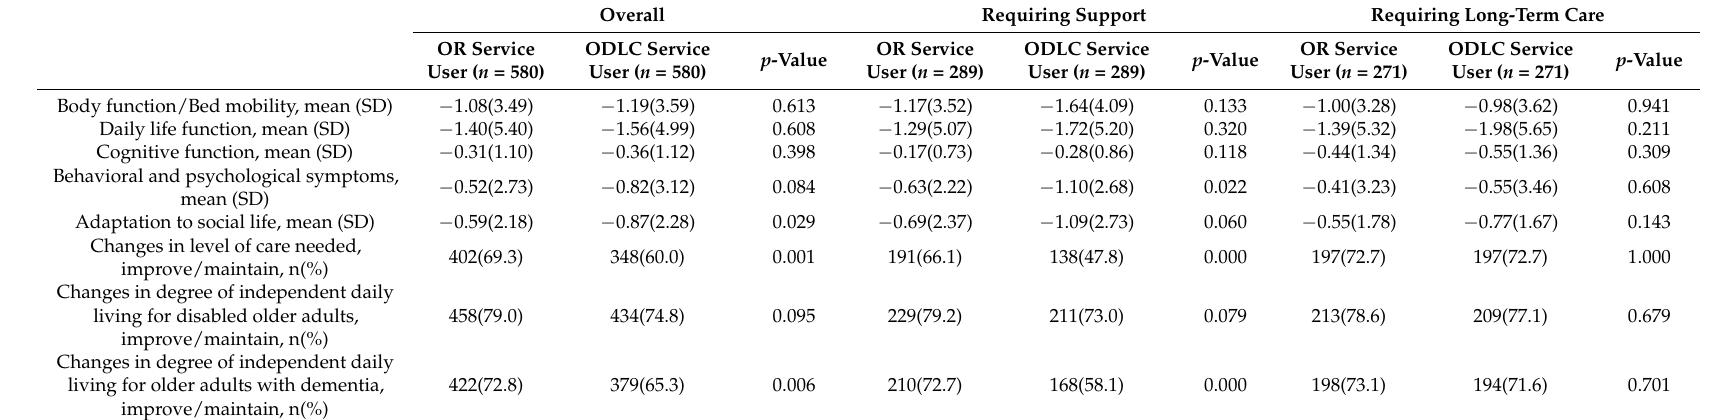
Table 5. Comparisons of changes in the level of care and function after 2 years between OR and